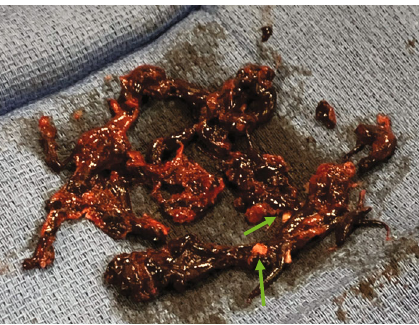
Figure 2: Thrombus removed during thrombectomy. White appearing thrombus (arrows) suggesting chronically organized